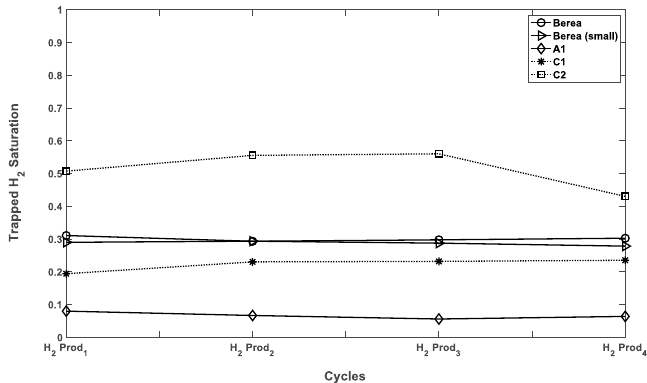
Figure 10. Sensitivity analysis of saturation of trapped hydrogen after 4 cycles of production for different rock ◦ ◦ types with advancing ( θ a = 81 ) and receding ( θ r = 10 ) contact angles and fluid properties of the